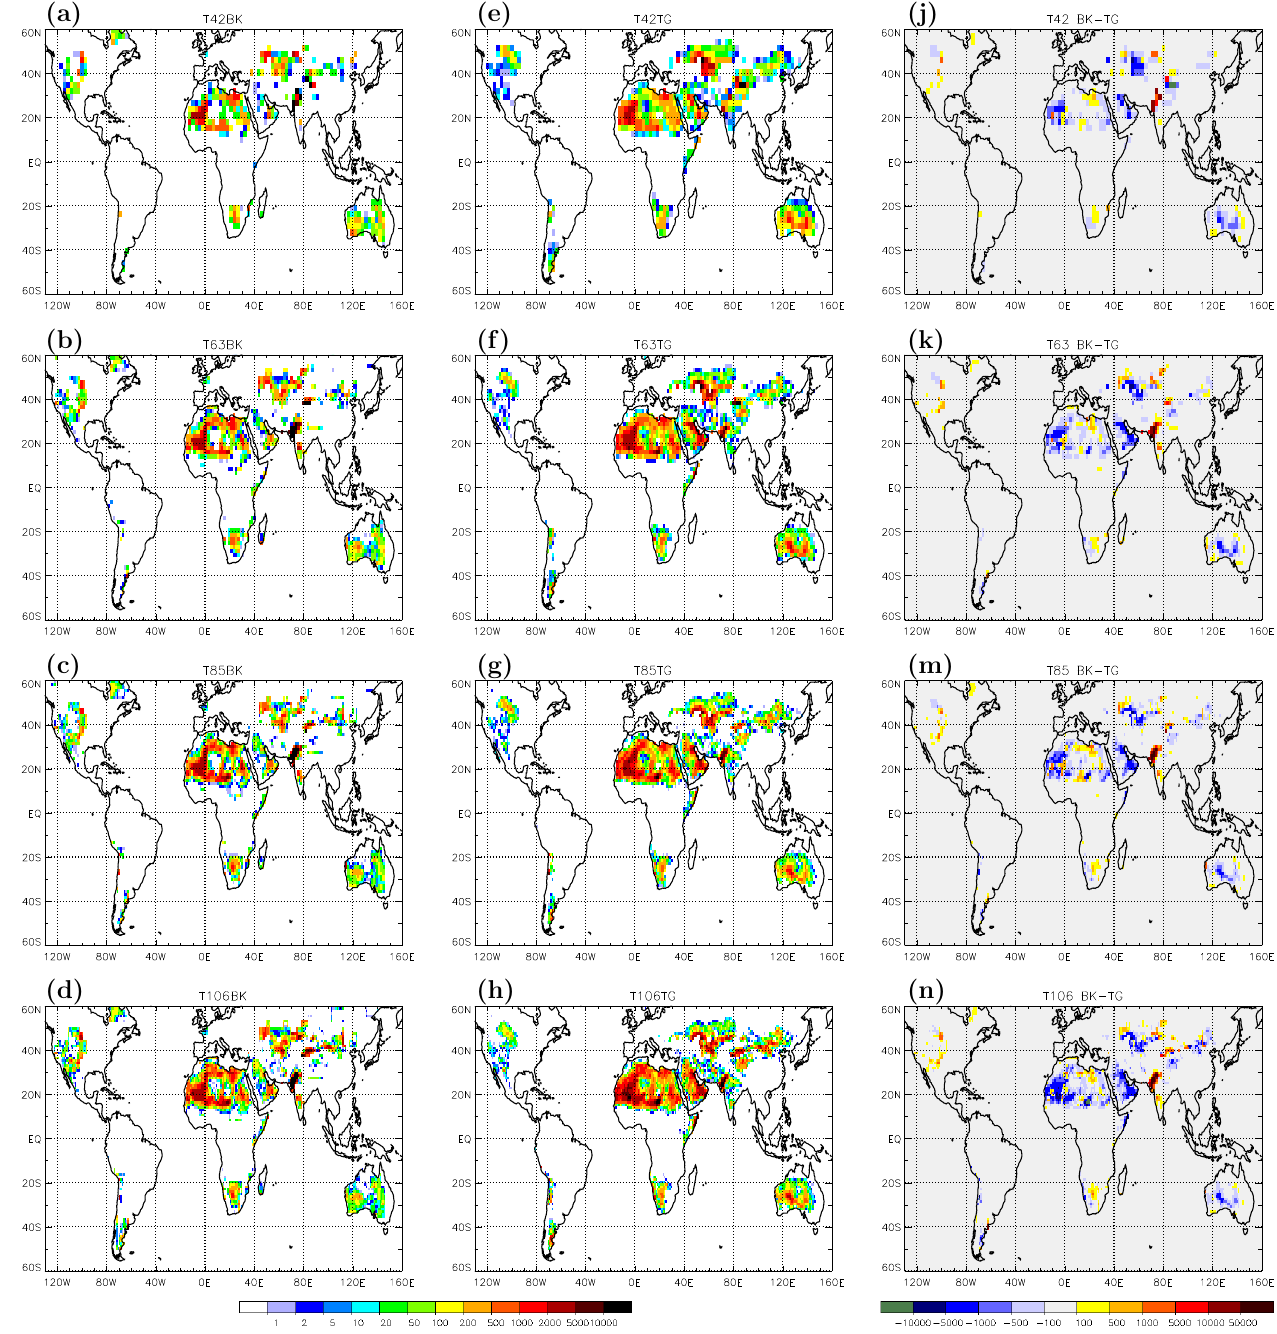
Fig. 2. Simulated five-year mean dust emission (kg ha − 1 yr − 1 ) using the dust emission schemes of Balkanski et al. (2004) (left column) and Tegen et al. (2002) (middle column) and for the spectral model resolutions T42 (1st row), T63 (2nd row), T85 (3rd row), and T106 (4th row). The right column shows the difference of BK minus